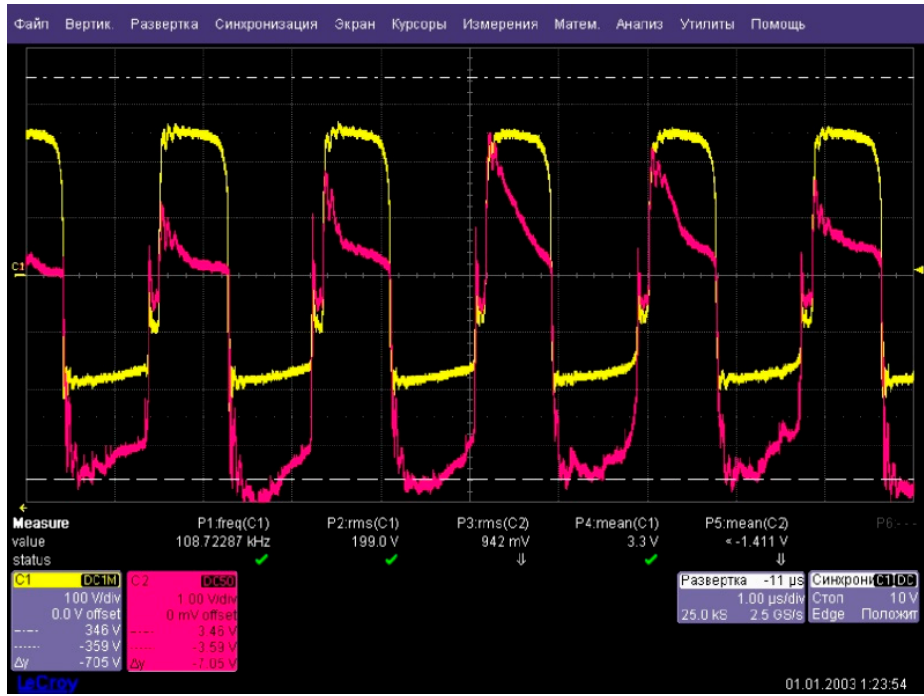
Figure 6. Oscillogram of current (red curve) and voltage (yellow curve) at the reactor input.